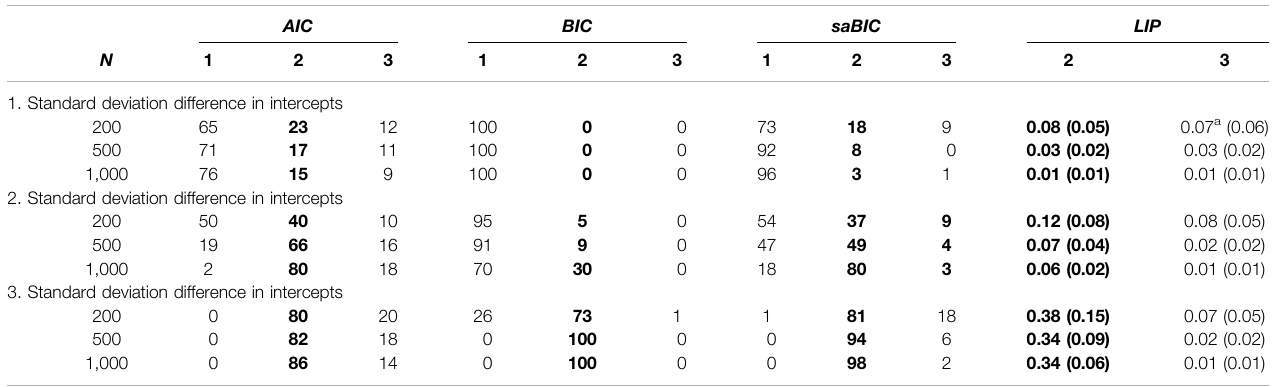
TABLE 2 | Model Selection in Growth Mixture Modeling Structures with intercept differences, fi ve time points, and 50 – 50 mixing proportion from Grimm et al. (2013) and Associated LIP